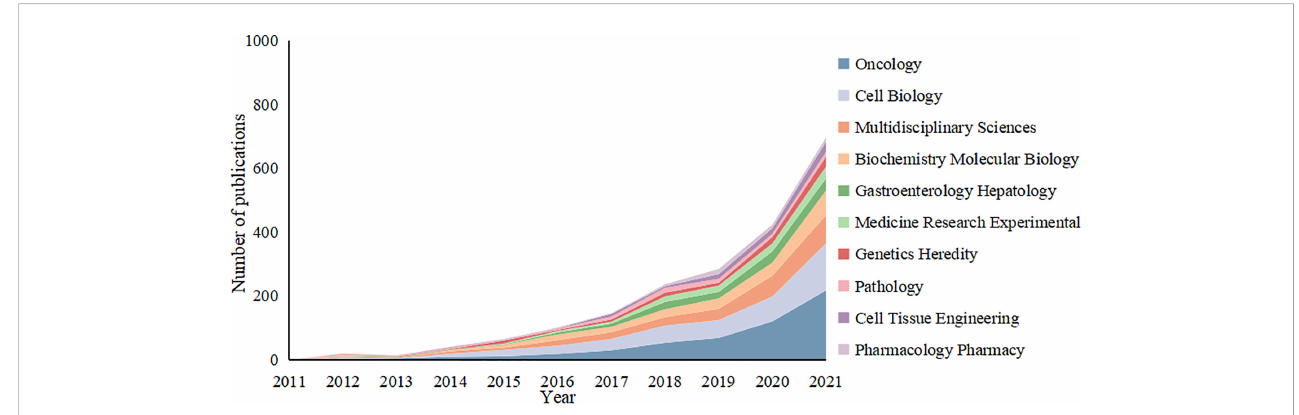
FIGURE 7 Variation curve of the number of published papers by main research direction of the tumor organoid research.